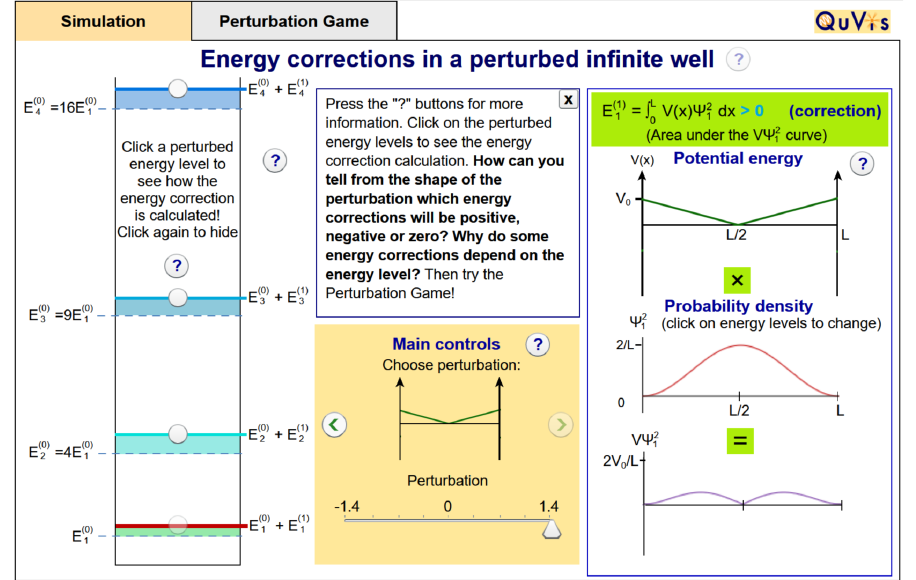
FIG. 5. A screen shot of the energy corrections in a perturbed infinite well simulation with the setup that students use for task E of the